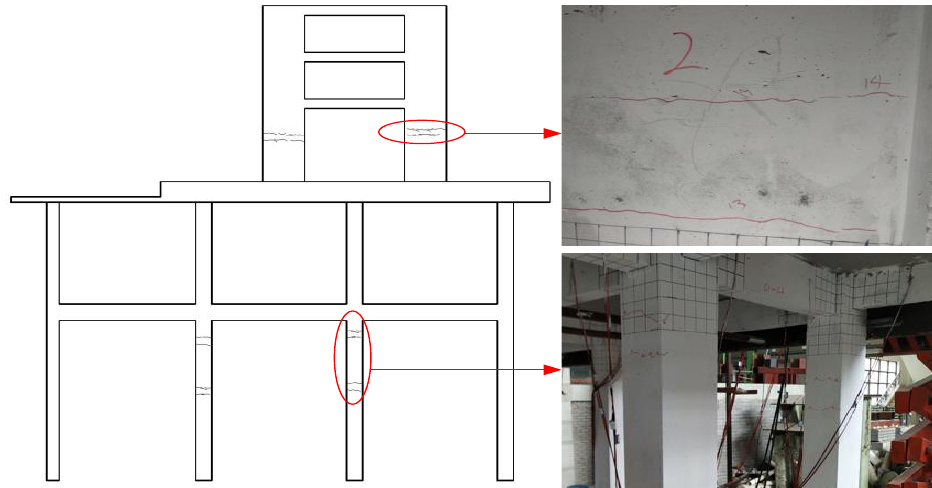
Figure 13. 7I-DBE damage condition. 8I-DBE damage condition: the cracks of the columns on the first floor increased,